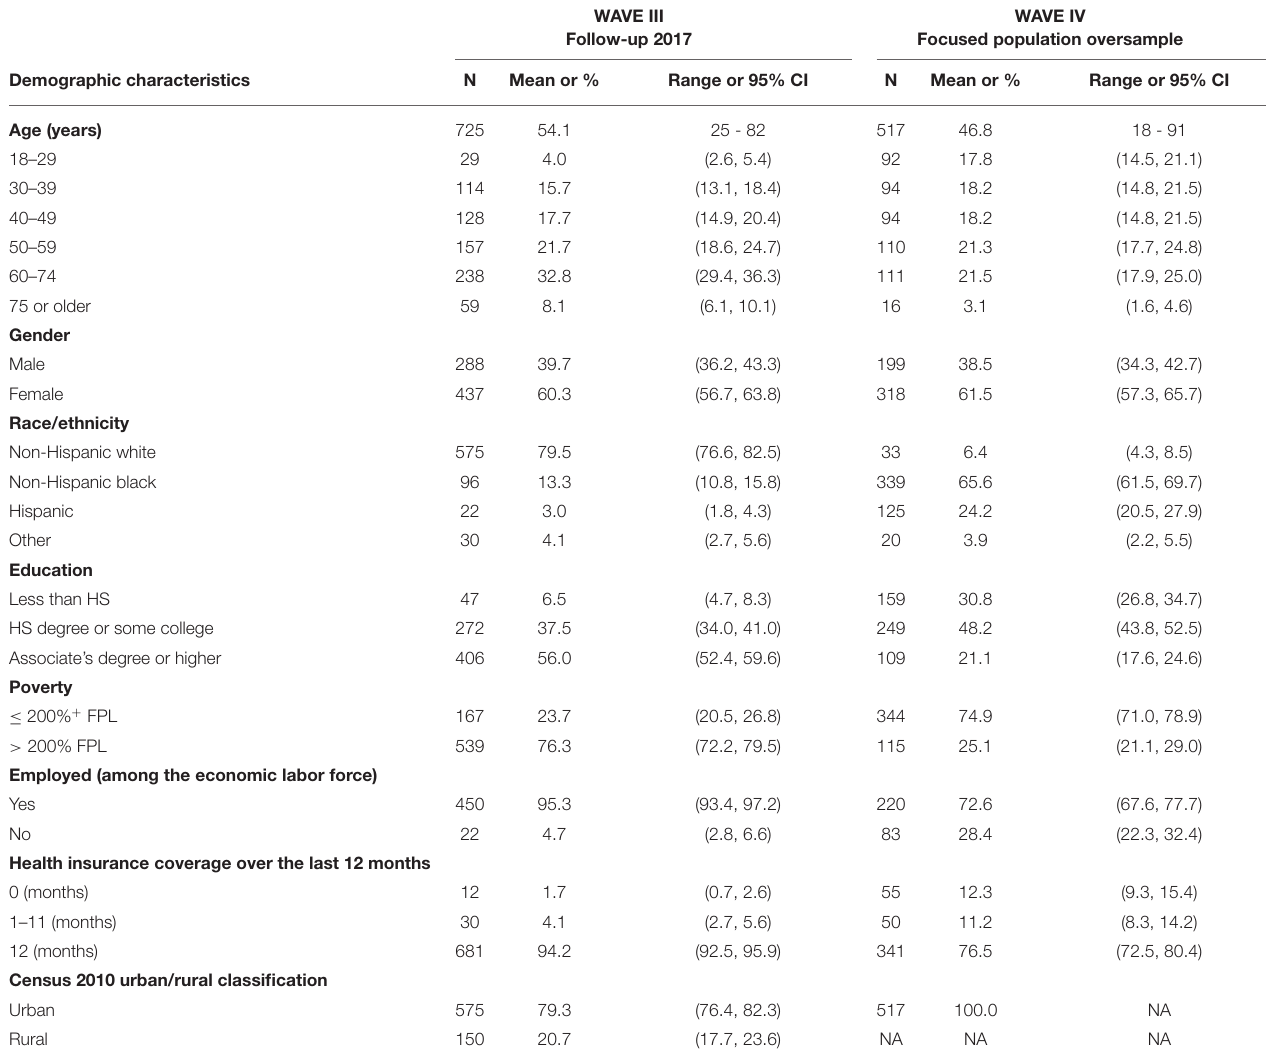
TABLE 2B | SHOW adults WAVES III and IV characteristics, unweighted.